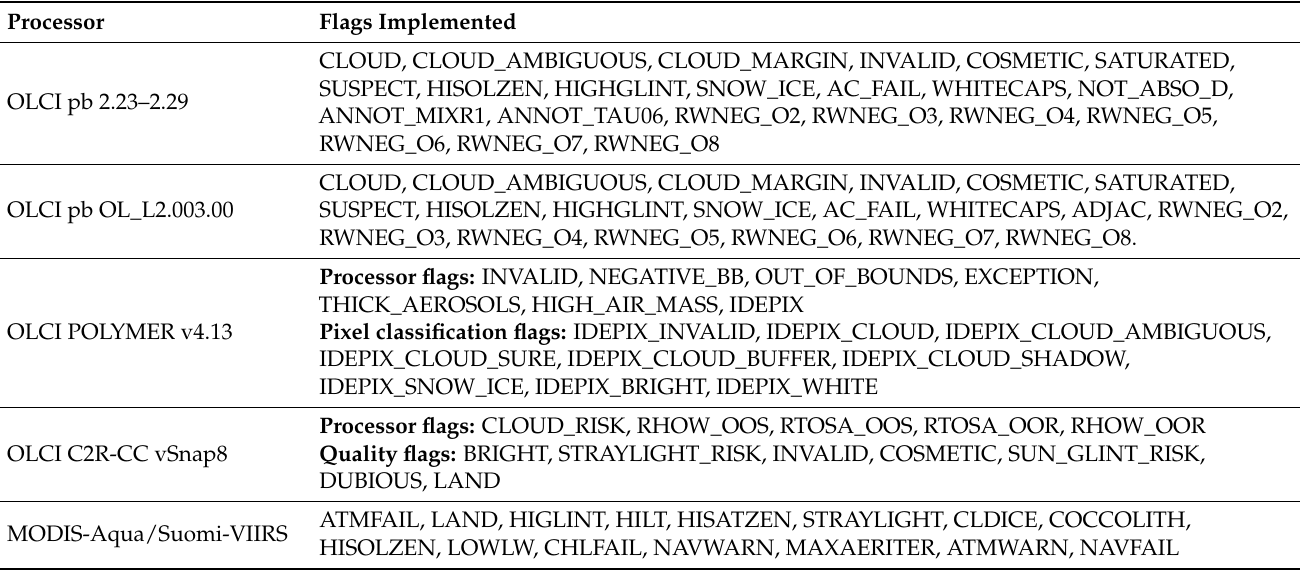
Table 1. Flags used to process each ocean colour R rs product. If any of the flags listed were raised, data for each product were not